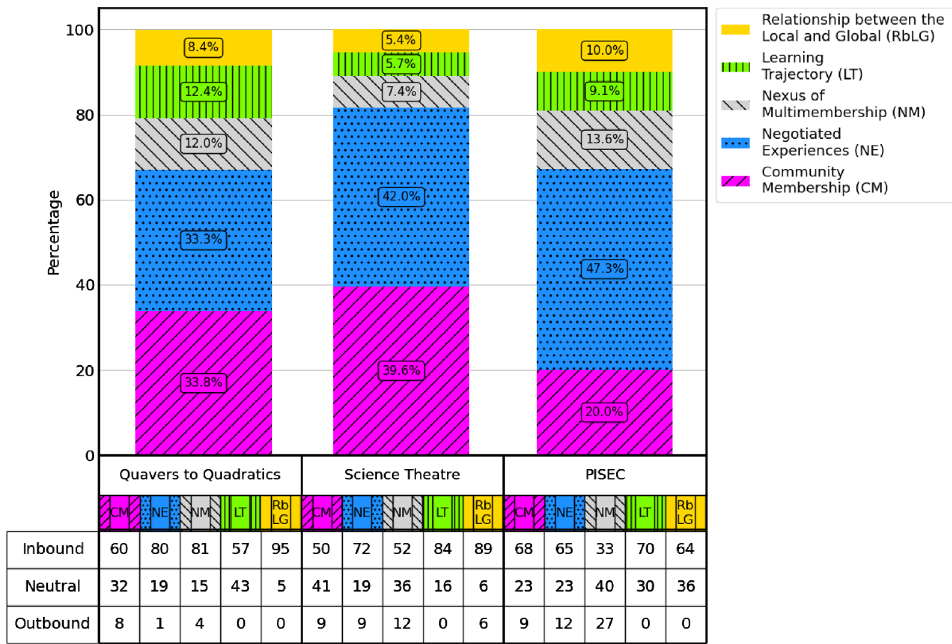
FIG. 3. The overall mechanisms of identity codes for each of the three informal programs (left to right: Quavers to Quadratics, Science Theatre, PISEC). The percentages shown in each bar indicate how many of the codes were assigned to each mechanism of identity out of all mechanisms of identity, and thus all the bars add up to 100%. The table shows the breakdown of each mechanism of identity into the subcodes with the percentage indicating how often the subcode was assigned to a given mechanism of